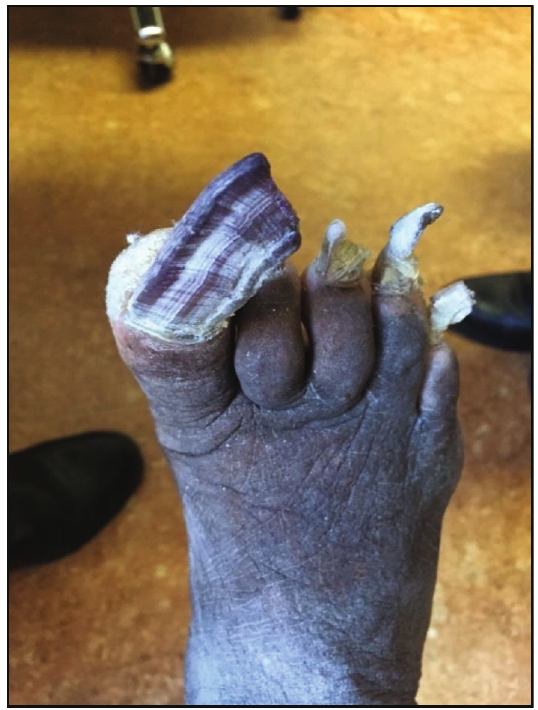
Figure 2: Dorsal view of the patient ’ s right foot. Note the overgrown toenails and dry